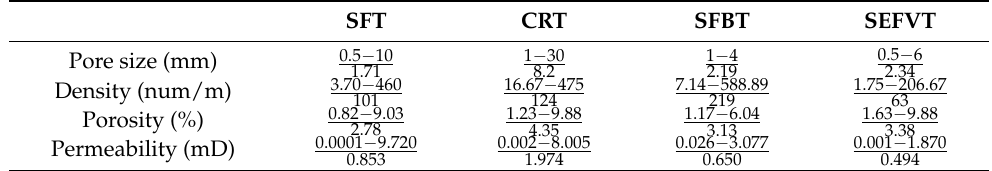
Table 3. Range and average of pore size, density and physical properties of void space types (SFT—solution-filling type;